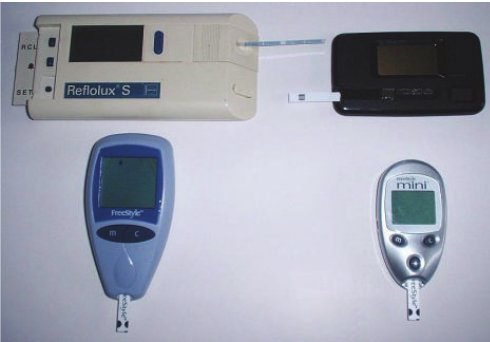
Figure 1: Four generations of blood glucose meter, c. 1993–2005.